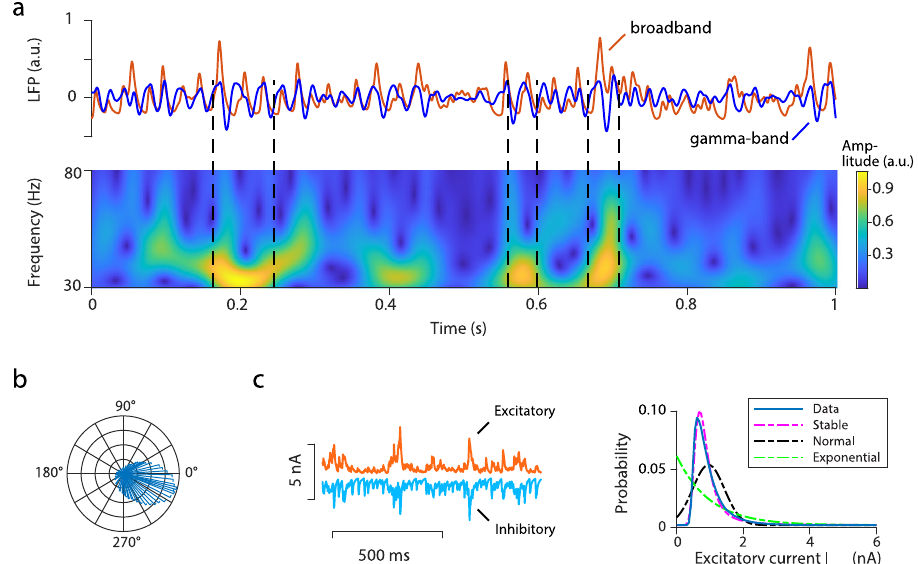
Fig. 5 Properties of gamma bursts in a neural circuit model. a Raw (red) and gamma-band fi ltered (30 – 80 Hz, blue) LFP time series. Lower panel shows the corresponding Morlet wavelet spectrogram of the gamma-band LFP time series. Black dashed lines denote gamma bursts. b Distribution of spikes of model excitatory neurons at different phases of gamma bursts, indicating phase-locking to gamma bursts. c Left: time series of excitatory and inhibitory inputs received by one model neuron over a period of 1 s. Note correlated and proportional fl uctuations in excitation and inhibition. Right: probability distribution of excitatory currents received by a single model neuron (blue). Magenta dashed line denotes a fi tted Lévy stable function ( α = 1.216) of the distribution. Normal distribution (black dashed line) and exponential function (green dashed line) are shown to be inadequate to describe the